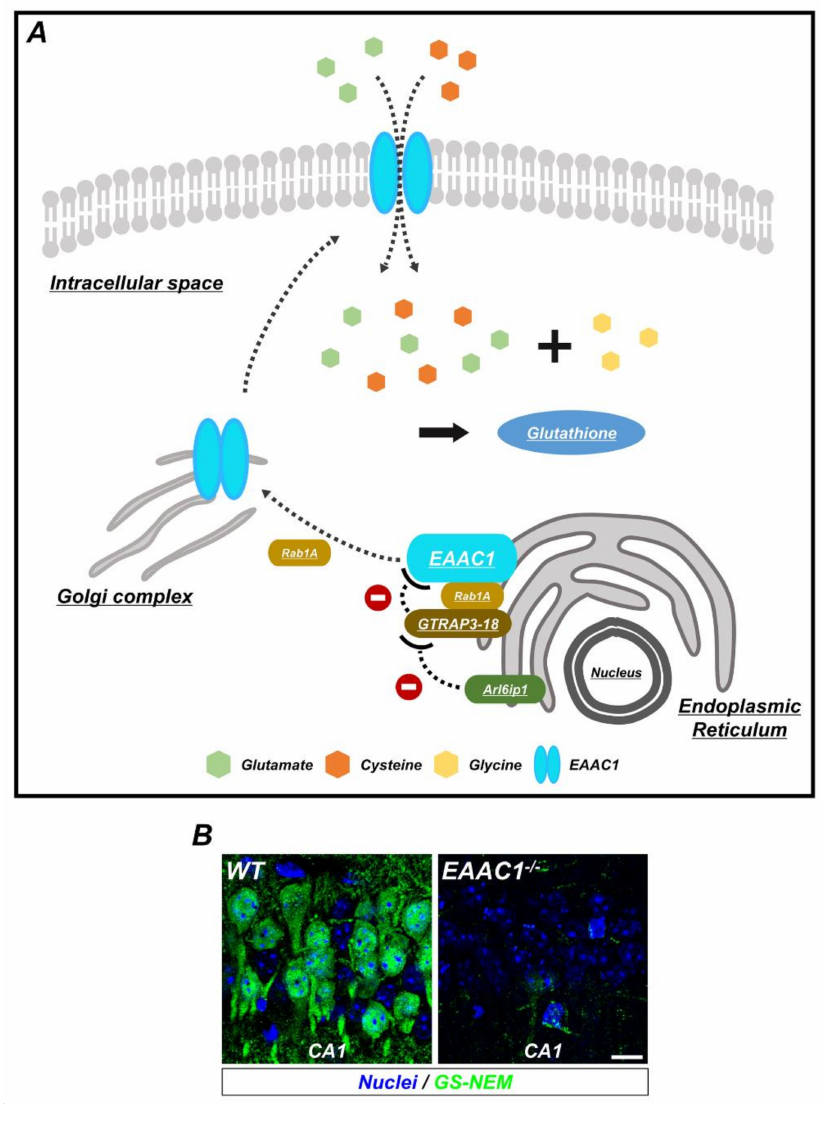
Figure 2. The synthesis of glutathione (GSH) by EAAC1 / glutamate transporter-associated protein 3-18 (GTRAP3-18) in neurons. ( A ) GSH is composed of three amino acids: Glycine, cysteine, and glutamate. To increase the synthesis of GSH, EAAC1 is translocated to the plasma membrane and transports cysteine and glutamate into the neuron. Ras-related protein Rab1A regulates several membrane-tra ffi cking pathways, including EAAC1 transport from the endoplasmic reticulum (ER) to the Golgi apparatus, which is interfered with when GTRAP3-18 binds to Rab1A. In addition, GTRAP3-18 directly retains EAAC1 in the ER to inhibit the synthesis of GSH. Thus, Arl6ip1, a GTRAP3-18-interacting protein, reduces GTRAP3-18 / EAAC1 interaction and positively regulates EAAC1-facilitated glutamate transport. ( B ) Immunofluorescence images showing the GSH-N-ethylmaleimide (GS-NEM) adducts in the neurons of hippocampal CA1 from WT and EAAC1 − / − mice. EAAC1 − / − mice (3–5 months old; weight 25–35 g) showed neuronal GSH deficiency. Scale bar = 10 µ